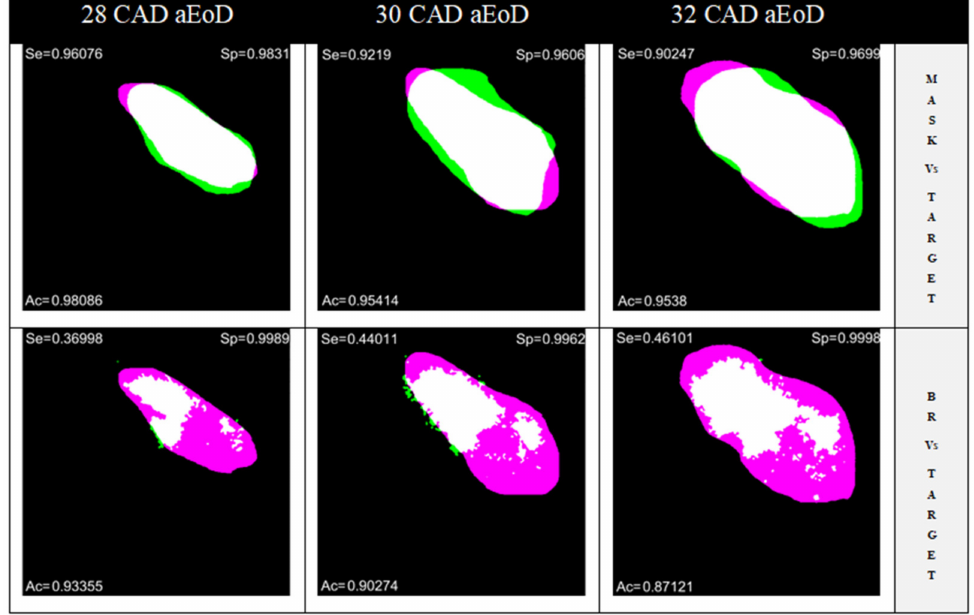
Figure 11. Evaluation of the metric at λ = 1.8 for two cases. Green area represents the overesti- mation performed by the tested method on detecting the target flame area; purple area, instead, the